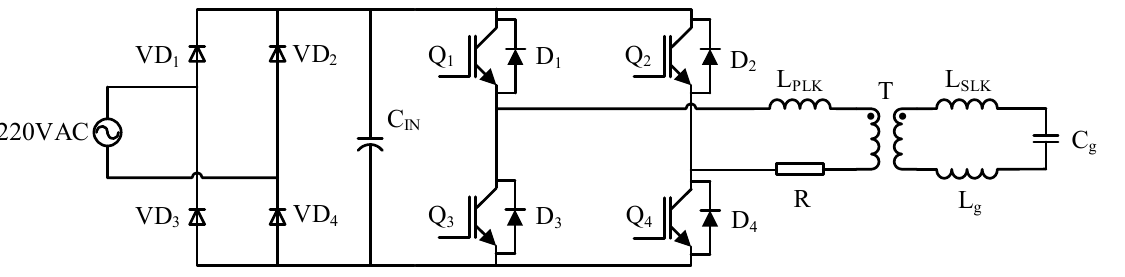
Figure 3. Main circuit diagram of resonant power supply for plasma cleaning.